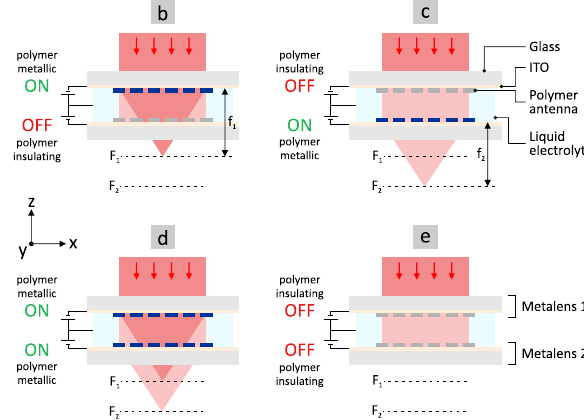
Fig. 1 | Concept of electrically switchable metalenses-on-demand and multi- functionalmetaobjectivefrommetallicpolymer.a Top:Schematicillustrationof a metaobjective comprising two electrically switchable metalenses on ITO(indium- tin-oxide) covered substrates. The metalenses consist of electrically switchable metallic polymer nanoantennas. An electrolyte is used as separation and to allow electrochemical switching. The refractive power of the polymer metalenses is switched ON or OFF on demand via an applied voltage of only +1V or − 1V,